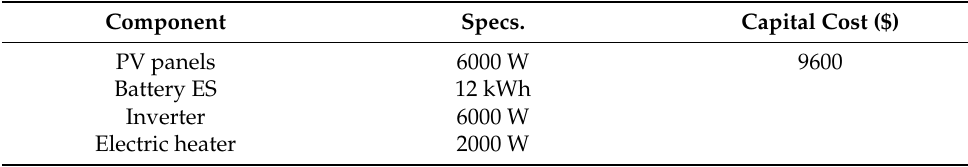
Table 1. System components